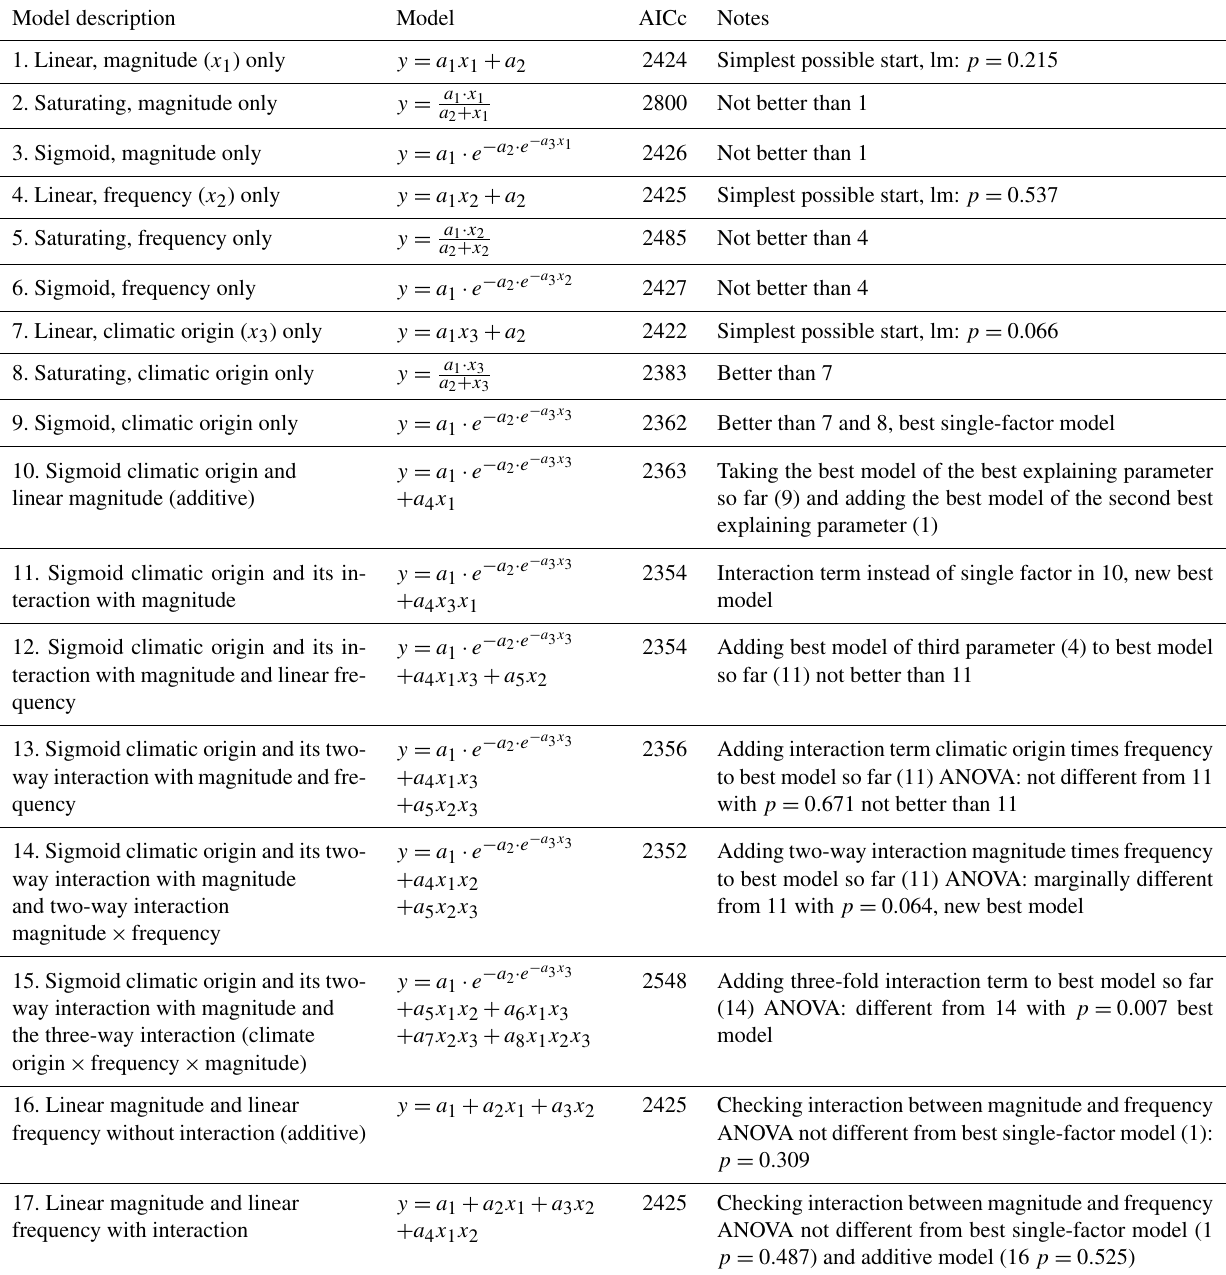
Table 3. Results of the hierarchical regression analysis for nitrate concentrations of beech forest soils with changes in FTC magnitude ( x 1 ), FTC frequency ( x 2 ) and climatic origin ( x 3 ; expressed as mean minimum winter temperature at origin) at the end of the FTC treatments. Tested are linear, saturating (Michaelis–Menten function), and sigmoid (Gompertz function) relationships on the single environmental drivers and their interactions. Bold AICc (Akaike information criterion corrected for small sample sizes) values indicate the best model. AICc in italics indicate the best single-factor models. a 1 to a n are the fitted parameters of the respective model. FTC: freeze–thaw